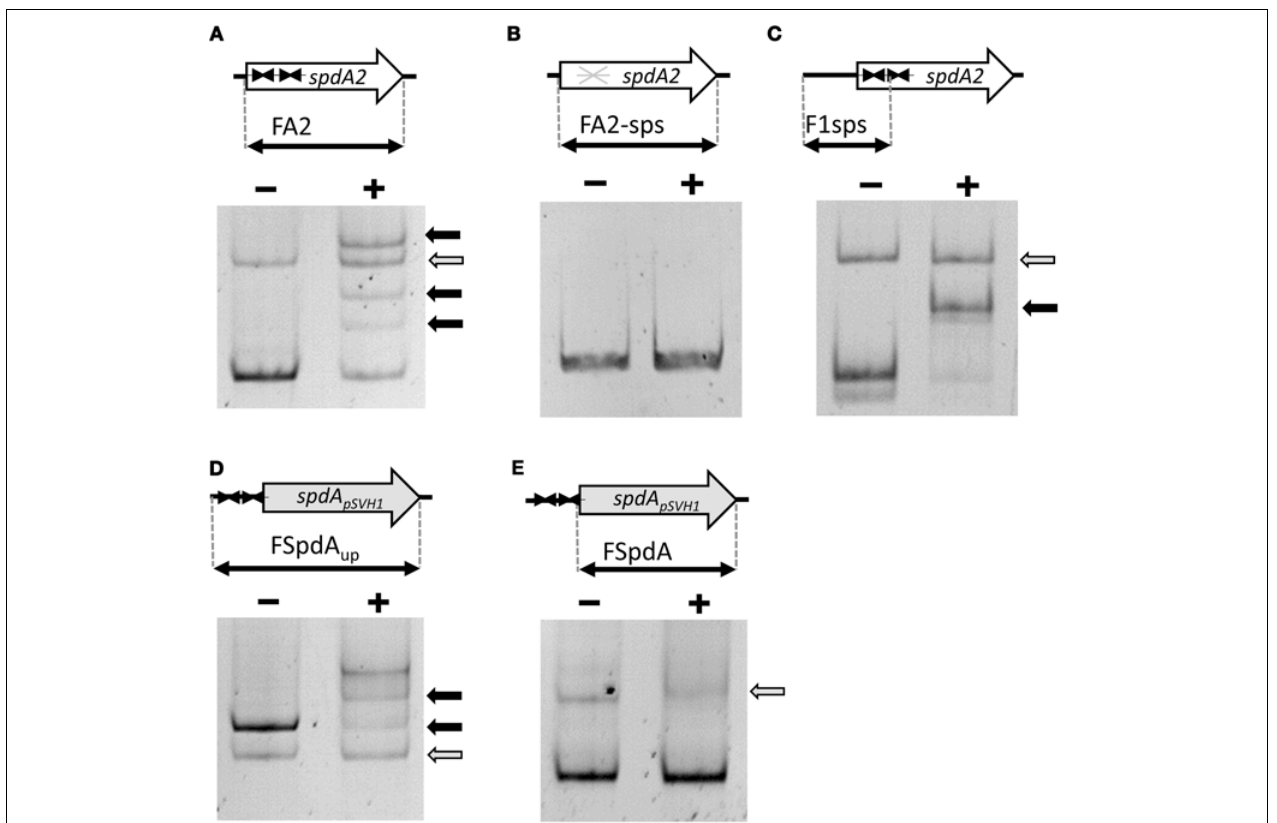
Black arrows mark retarded DNA fragments. Interaction of SpdA2-His with the FA2 fragment resulted in several retarded bands (A) . Whereas SpdA2-His did not interact with the FA2-sps fragment (B) , SpdA2-His shifted fragment F1sps, containing a single palindromic sps sequence (C) . SpdA2-His also bound to the PCR fragment FSpdA up , containing a T insertion within the palindromic sequence sps (D) , but did not recognize FSpdA, lacking sps (E)